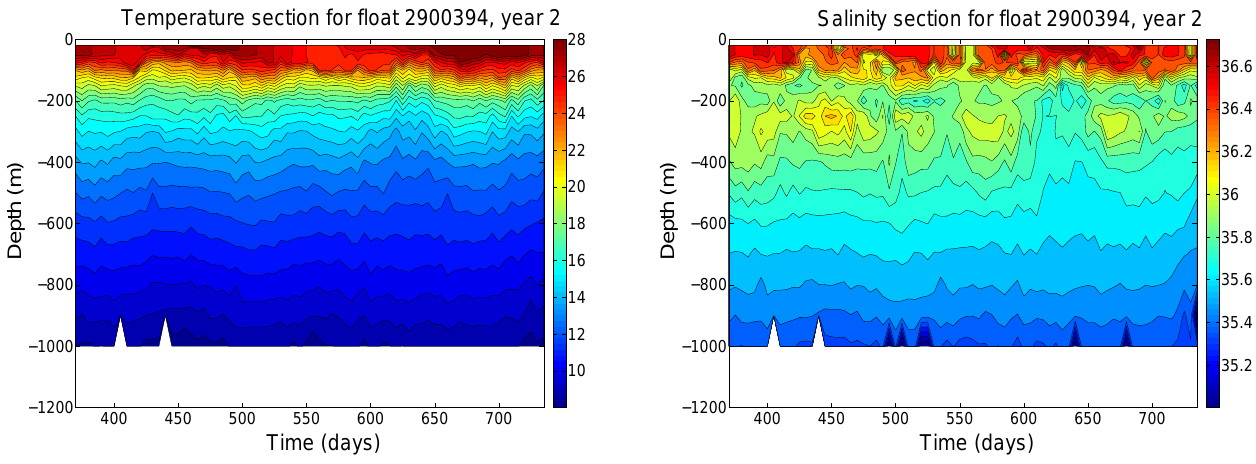
Fig. 25. Vertical sections of temperature (in ◦ C, left) and of salinity (right) along float 2900394 trajectory for year 2. Figure 25: Vertical sections of temperature (in o C , left) and of salinity (right) along float 2900394 trajectory for year 2. Intense thermohaline anomalies were measured at the depths of PGW or of